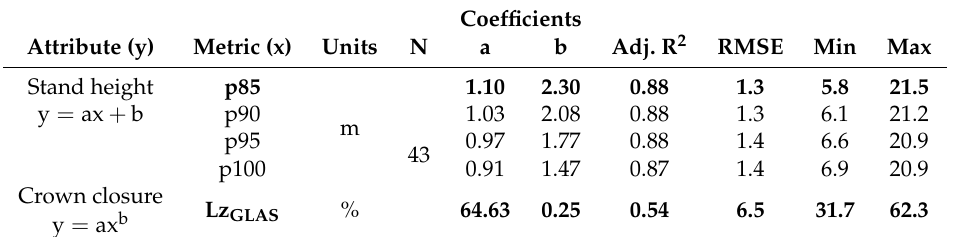
Table 4. Resulting model coefficients and fit statistics for testing Geoscience Laser Altimeter System (GLAS) height metrics and scaled Lz metric against areal LiDAR modelled stand height and crown closure equivalents. P85 was determined as optimal as it exhibits most favourable Adj. R 2 , RMSE, and greatest predictive range. Implemented models are bold. Note, min and max are the minimum and maximum model predictive ranges, respectively.